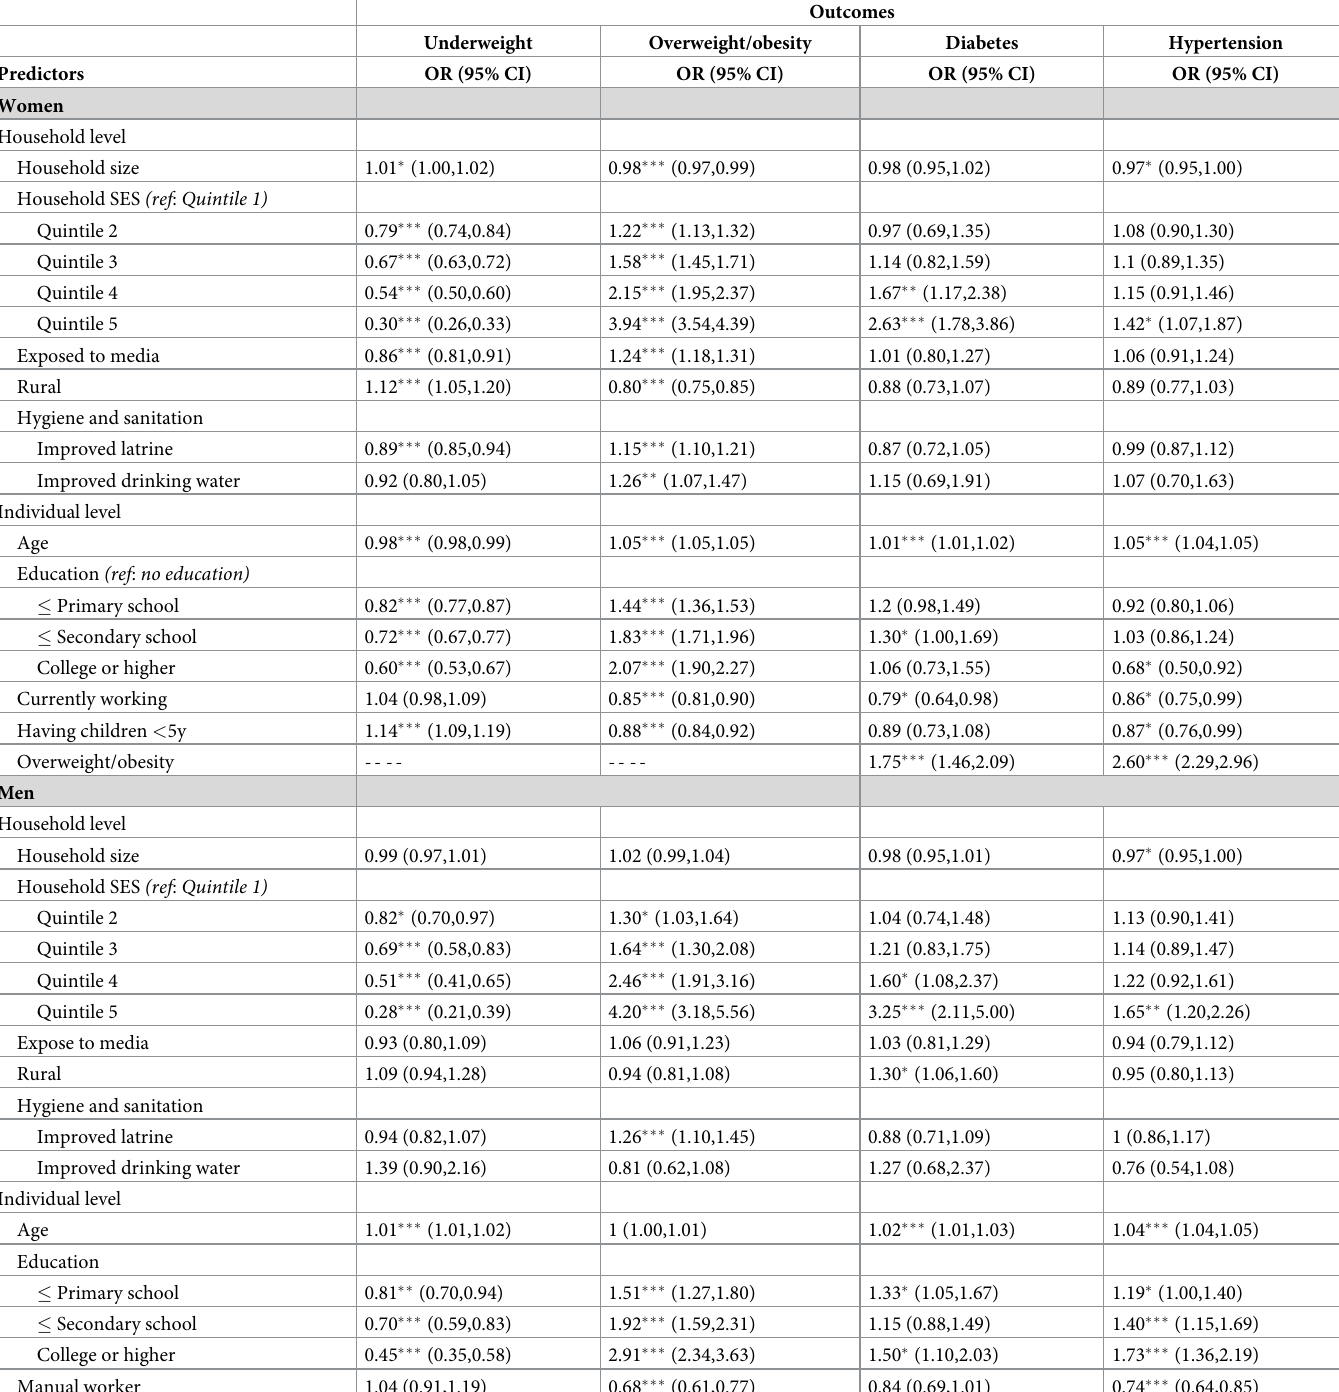
Table 2. Associations between selected factors and